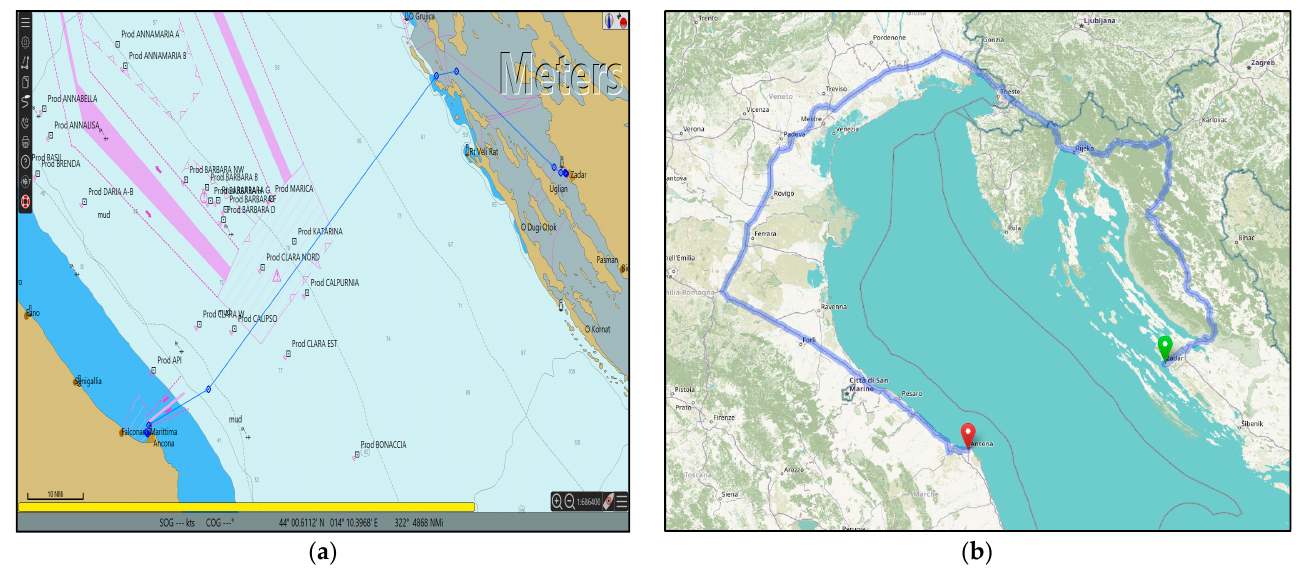
Table 11. Determined distances on route 𝑅 (cid:2870) .